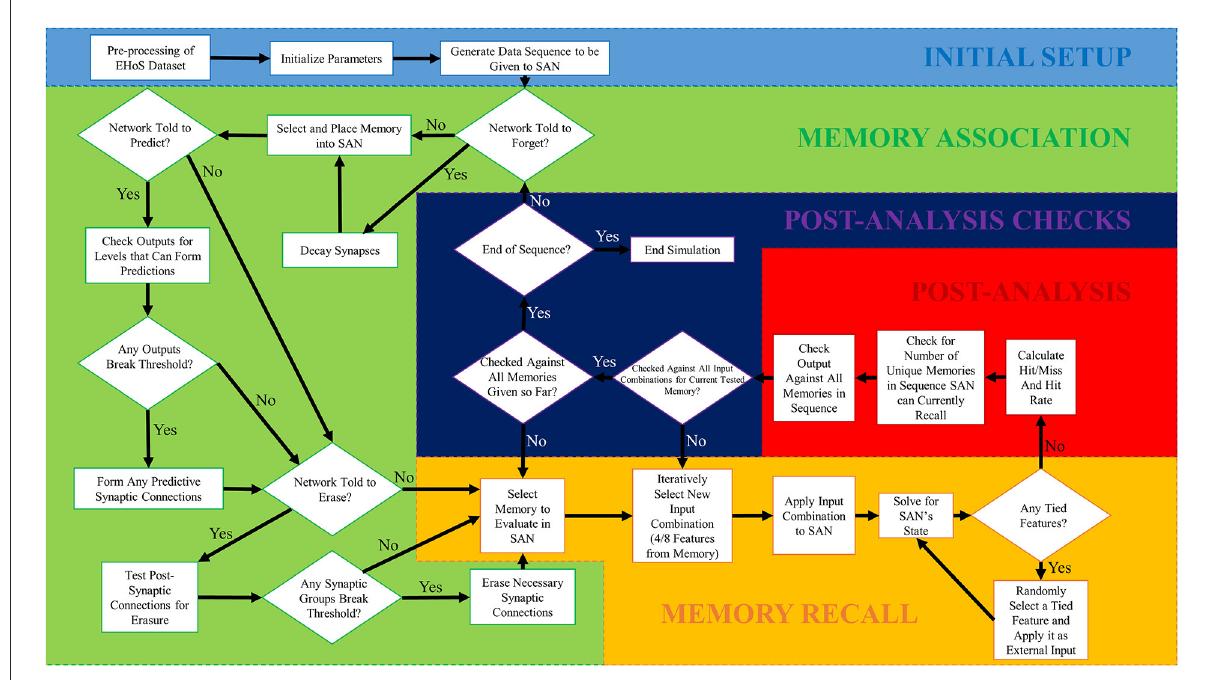
FIGURE2 Simulation flowchart for the SAN simulation process conducted in MATLAB. There are five phases to the simulation process, with the first one only being ran once. The remaining four phases are ran iteratively in order to simulate the network over a total of 700 time steps. One memory from the EHoS dataset was introduced to the network at each individual time step, with the network’s state being paused between time steps to evaluate its current recall capability.